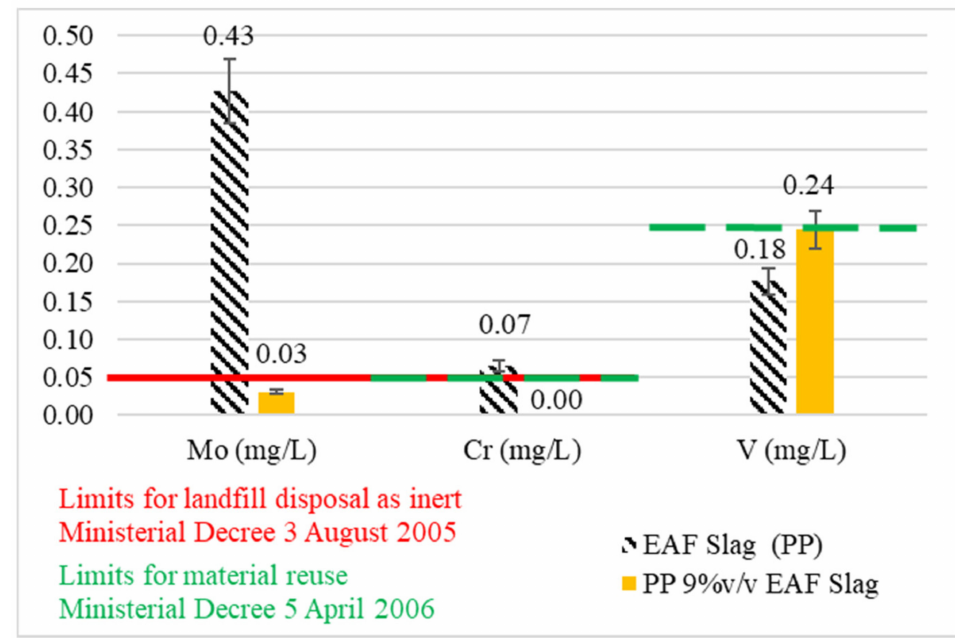
Figure 2. Leaching test results average and standard deviation. The leaching of Cr, Mo, and V is determined according to the standard CEN EN 12457-2 on free EAF slag and on NBR, ELT, Epoxy resin and PP filled with EAF slag (grain size < 106). The leaching limits imposed by Italian legislation are shown as horizontal red and green